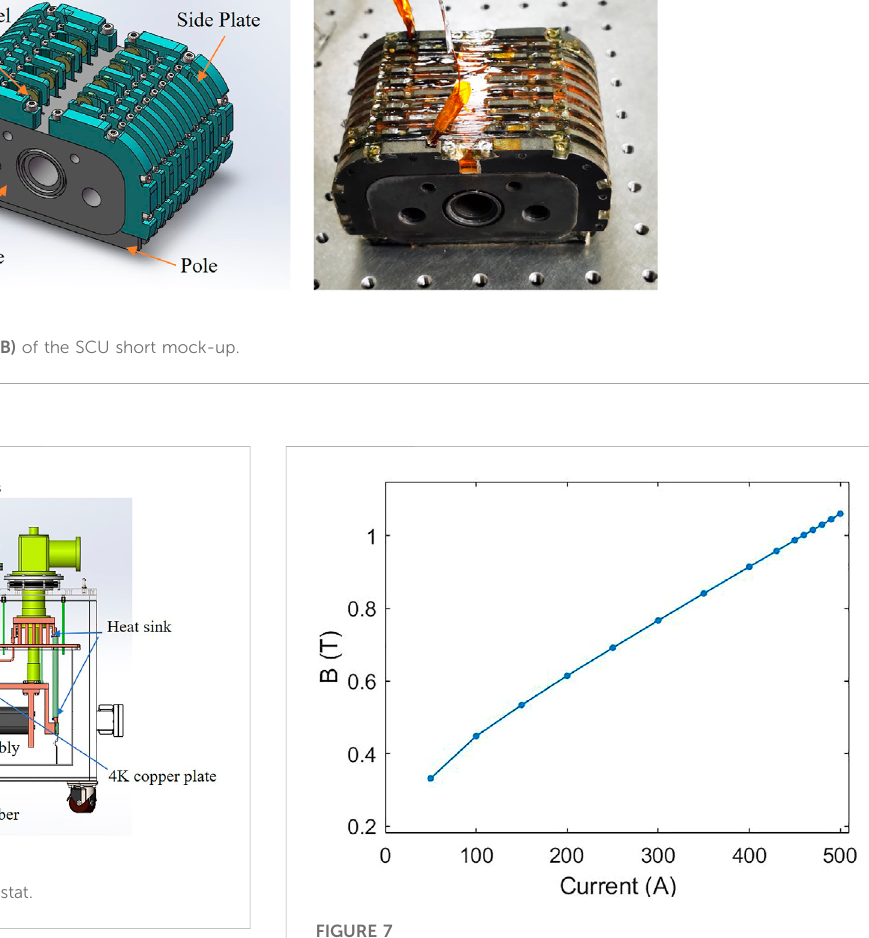
FIGURE 7 Relation curve between the peak magnetic fi eld and the load current for short mock-up